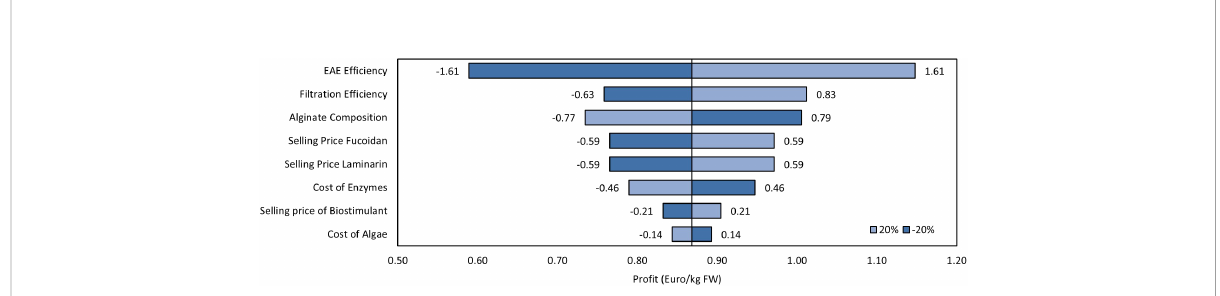
FIGURE 7 Tornado diagram of sensibility analysis for laminarin production with S. latissima with change in pro fi t as a function of ±20% variation in each parameter and, labeled the elasticity coef fi cient for each evaluated